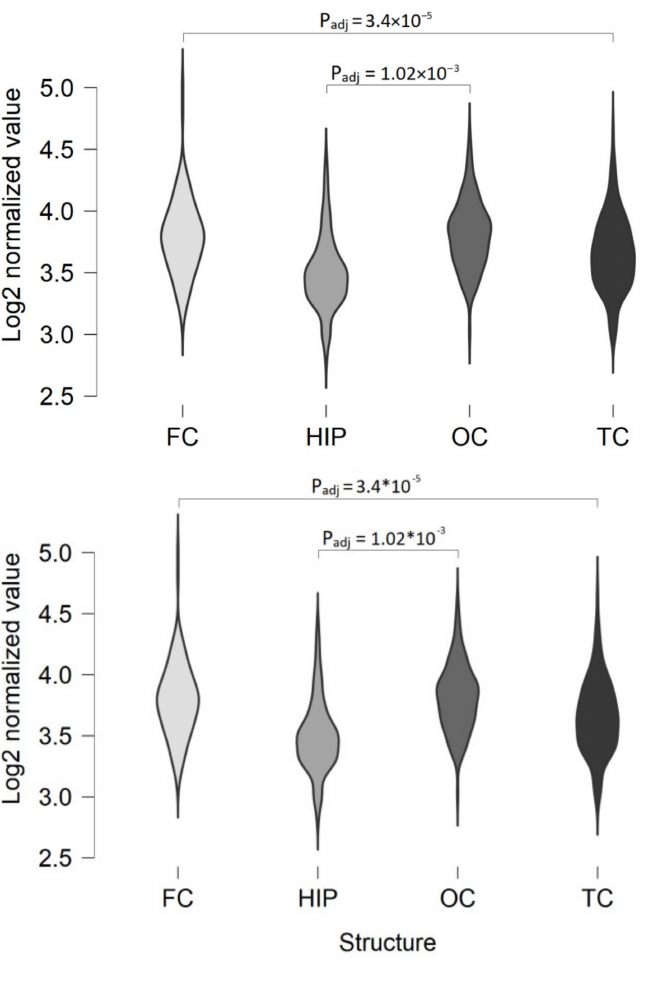
Figure 1. TAAR5 expression in different human cortex areas (GSE46706). FC—frontal cortex ( n = 127), HIP—hippocampus ( n = 122), OC—occipital cortex ( n = 129), TC—temporal cortex ( n = 119).